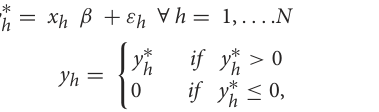
to five, with an increase of 2.7% for LPs and 14.0% for